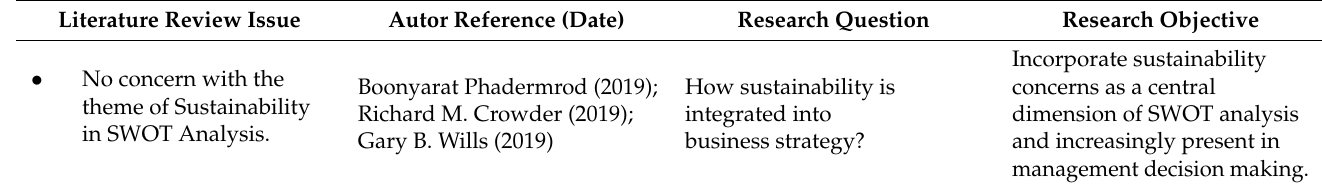
Table 1. Research instrument and